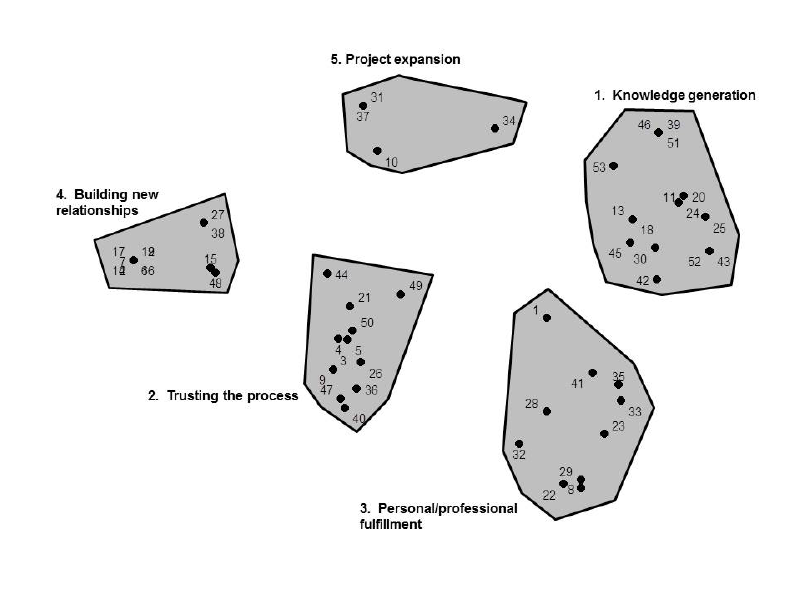
Figure 2: Based on